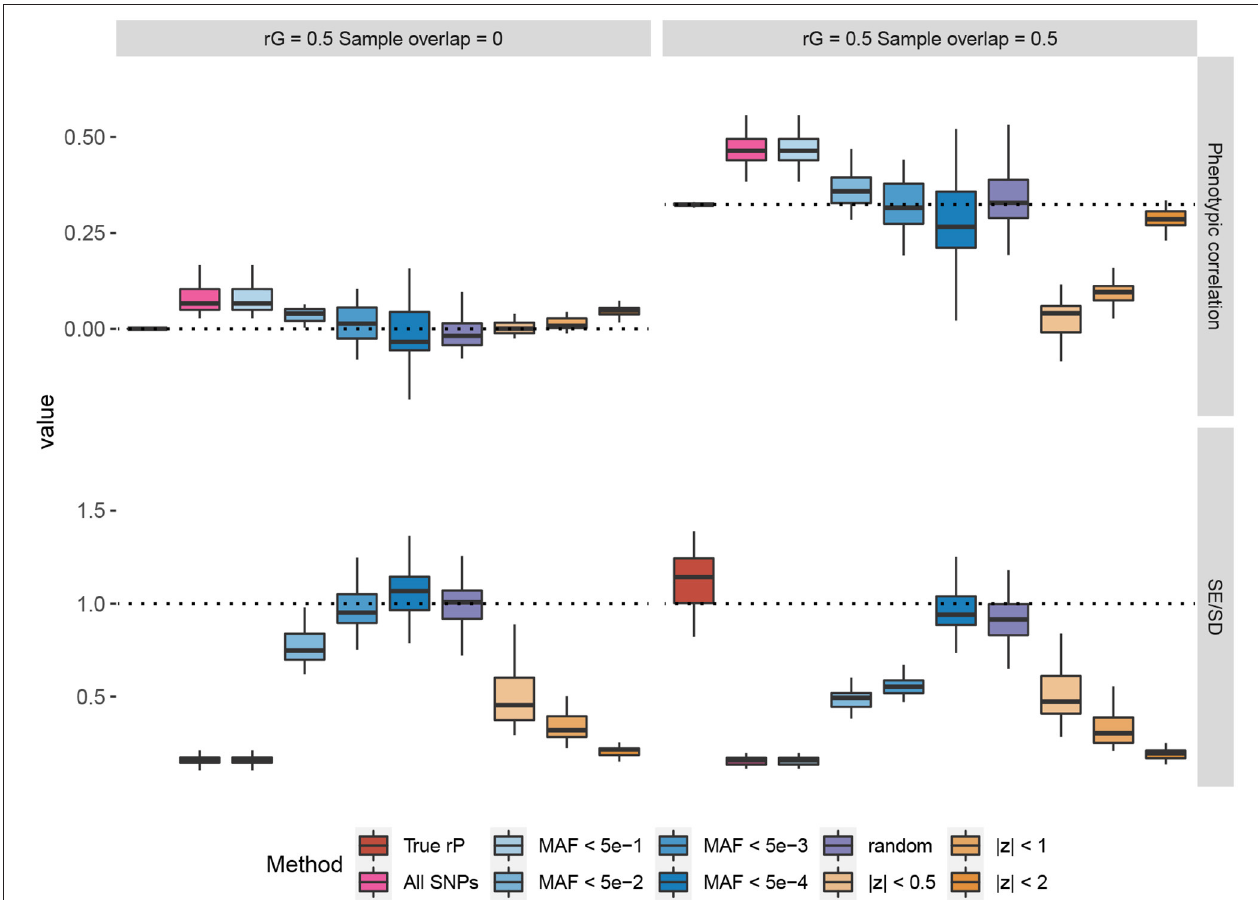
FIGURE 1 | Simulations comparing the Z-cut and low minor allele frequency (MAF) estimators for phenotypic correlation. The box plots show the simulation results from 30 replicates, where in each replicate, two phenotypes with heritability of 0.3 were simulated based on 10% randomly selected causal single nucleotide polymorphisms (SNPs) from the 784,256 genotyped SNPs in the UK Biobank. The true genetic correlation (rG) were set to 0.5 and the residual correlations were set to 0.25 for each pair of traits. Two scenarios of sample overlap proportions are shown. In the top panels, each phenotype was simulated for 168,000 genomic British individuals. The box plots compare the estimated phenotypic correlations using different estimators. The dash lines represent the true values. The bottom panels compare the estimated standard errors (SE) across the replicates to the standard deviation (SD) of the phenotypic correlation estimates across the 30 replicates, and each phenotype was simulated for 1,000 genomic British individuals. The dash lines at 1 represent that the estimated SE matches the empirical sampling SD. The “random” method represents the estimator based on 500 simulated SNPs with random genotypes and zero genetic effects. The true phenotypic correlation (rP) estimator was based on the individual-level phenotype data. The other estimators were based on the SNPs on chromosome 22 (numbers given in Supplementary Table 3